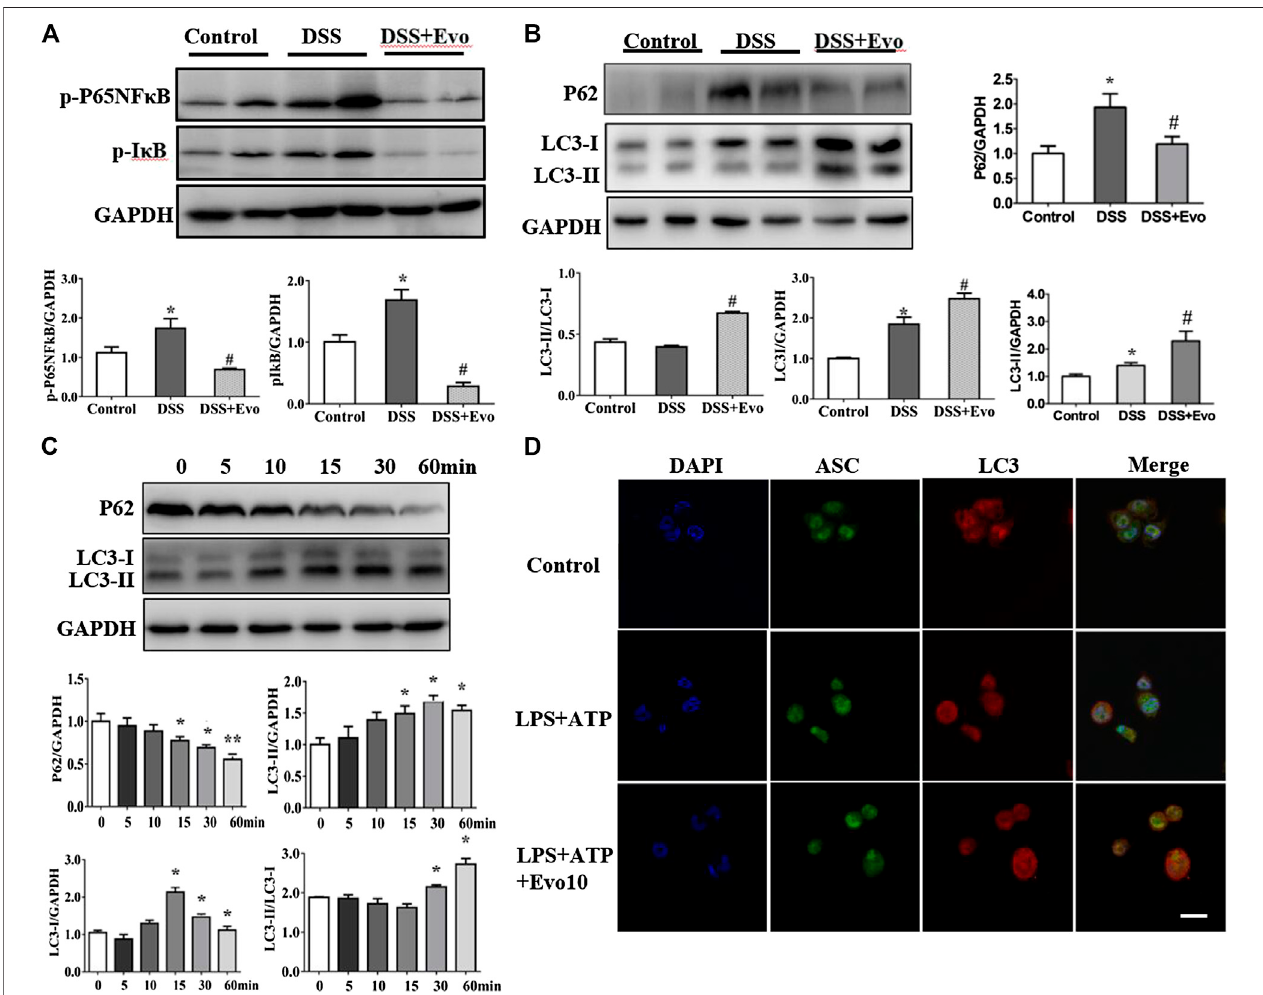
FIGURE 5 | Evodiamine increased autophagic fl ux in colitis mice and differentiated THP1 cells. (A) Immunoblot analysis of p-P65, p -I κ B expression in mice colon and quanti fi cation. (B) Immunoblot analysis of p62, LC3 expression in mice colon and quanti fi cation. (C) Expressions of p62 and LC3 in THP-1 cells stimulated with evodiamine (10 μ M) at various time determined by immunoblot and quanti fi cation. (D) Representative confocal fl uorescence microscopy images of THP-1 cells incubated with LPS and ATP in the presence or absence of evodiamine (10 μ M) and immunostained for ASC (green) and LC3 (red). Nuclei were stained with the DAPI (blue). Scale bar, 10 μ m. The data are representative of three independent